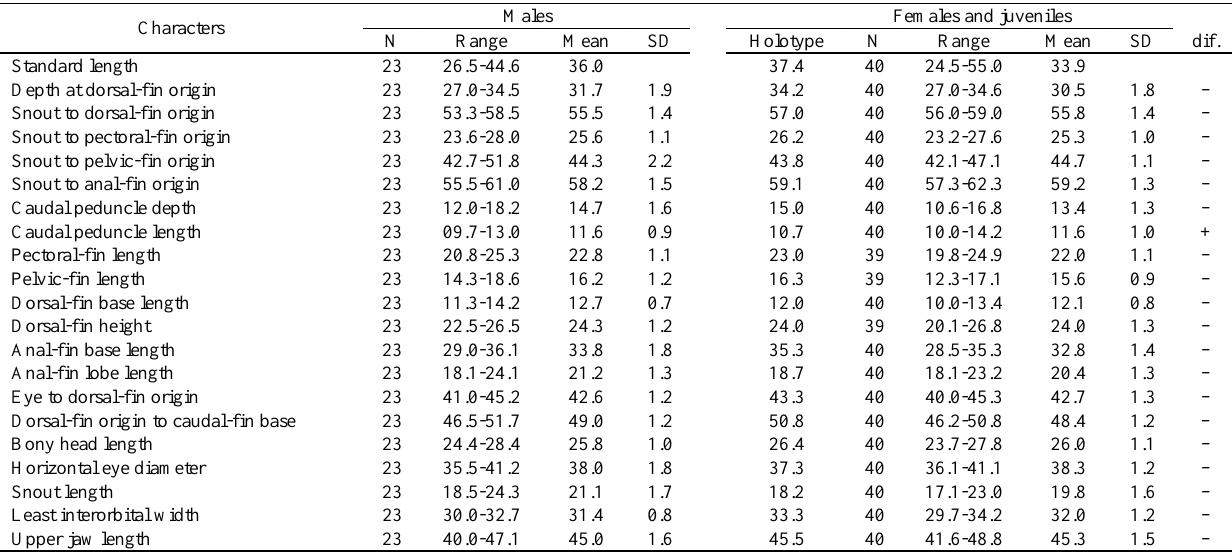
Table 3. Morphometrics of Glandulocauda melanopleura . Standard length is expressed in mm; measurements through bony head length are percentages of standard length; the last four entries are percentages head length. A plus sign under the abbreviation dif indicates there is a significant statistical difference between the males and females in the particular character indicated. All specimens are from Campo Grande/Paranapiacaba region, headwaters of rio Tietê, São Paulo: FMNH 54891 (Holotype of G . melanogenys ), FMNH 892, FMNH 15025, FMNH 15026; MZUSP 28849, MZUSP 35242, MZUSP 1869, MZUSP 26890, MZUSP 26891, MZUSP 26892; CAS(IUM) 13287; USNM 236414, USNM 236415. SD = Standard